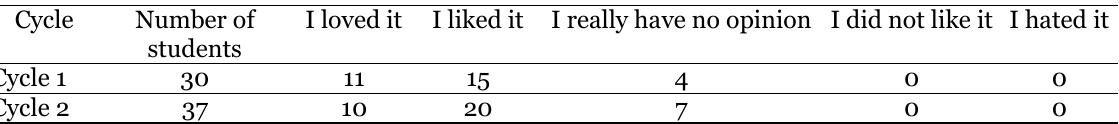
Overall Response to the Playful Approach Adopted in the Course